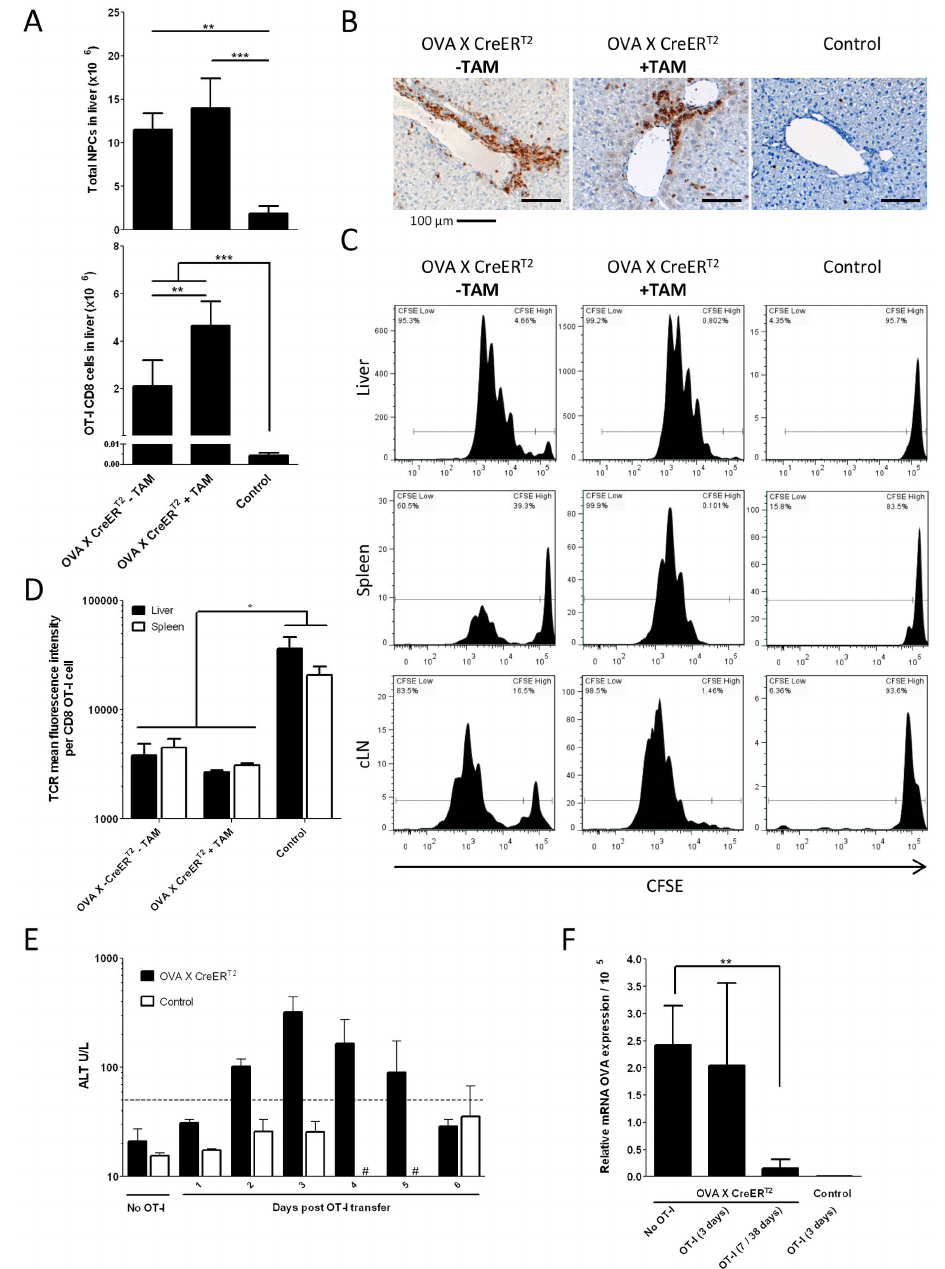
Figure 2. Antigen-driven liver infiltrations and fate of adoptively transferred OT-I T cells. Adoptive transfer of OT-I CD8+ cells to the OVA_X_CreER T2 mice either pre-treated with TAM (day -30) or untreated was performed. For analysis mice were sacrificed at day +3 post adoptive transfer. A . Accumulation of NPCs and OT-I CD8+ T cells in the liver at day +3 post adoptive transfer (n=6-10). B . T cells infiltrating the liver tissue post adoptive transfer. T cells were visualized by indirect immunohistochemical staining using anti-CD3 antibody (brown). Data from representative mice are shown. C . Proliferation of OT-I CD8+ T cells quantified by CFSE dilution. Cells were re-isolated on day +3 post transfer. Histograms from representative mice are shown. D .T cell receptor down-regulation on OT-I CD8+ T cells as determined by staining with the PE labelled OVA antigen specific tetramers (n=4). E . Liver damage assessed by ALT activity measured in blood plasma of OVA_X_CreER T2 mice. ALT activity below 40 U/L is considered as physiological, dashed line (n=3-10), # - not done. F . Elimination of OVA antigen expressing hepatocytes. ‘ON-state’ OVA mRNA expression in liver samples quantified by qRT-PCR (n=5-8). As control, 4 single transgenic OVA or CreER T2 animals were treated with TAM and adoptively transferred with OT-I cells. doi: 10.1371/journal.pone.0068720.g002 PLOS ONE |